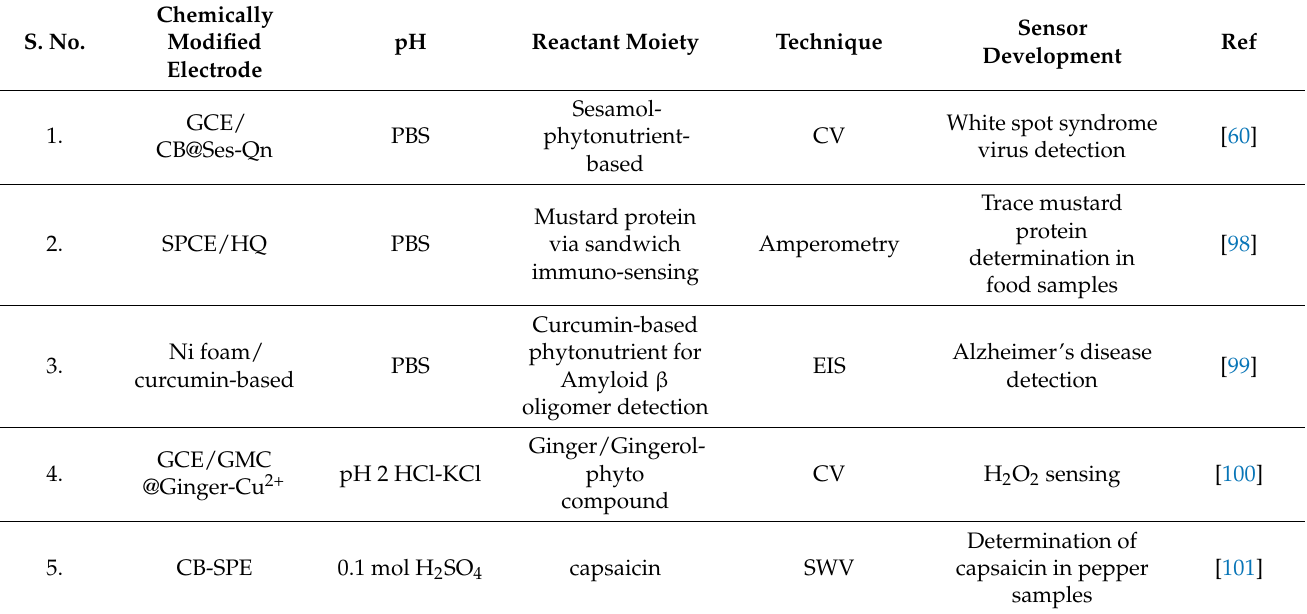
Table 6. Account for various sensing platforms used with different